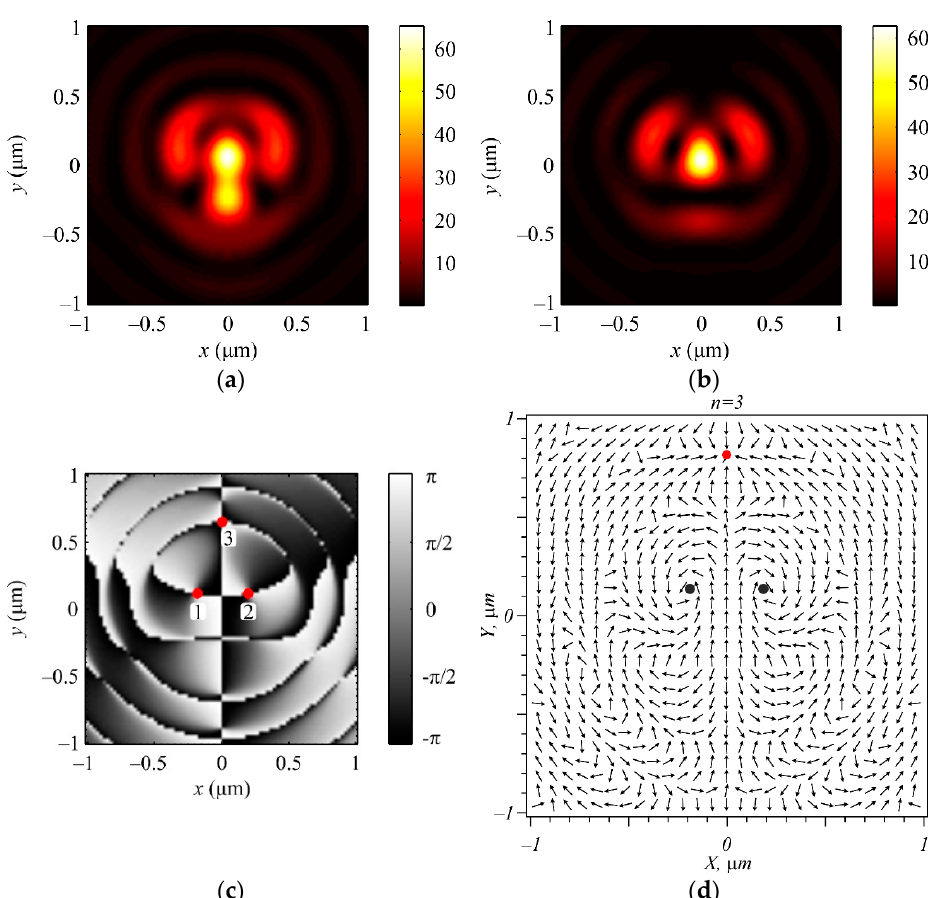
Figure 3. ( a ) An intensity I = Ix + Iy + Iz , ( b ) amplitude, and ( c ) phase of the complex Stokes field (20) when focusing field (1) at n = 3. ( d ) A pattern of linear polarization vectors at the focus: black V-points of the ‘center’ type and red V-point of the “knot” type.